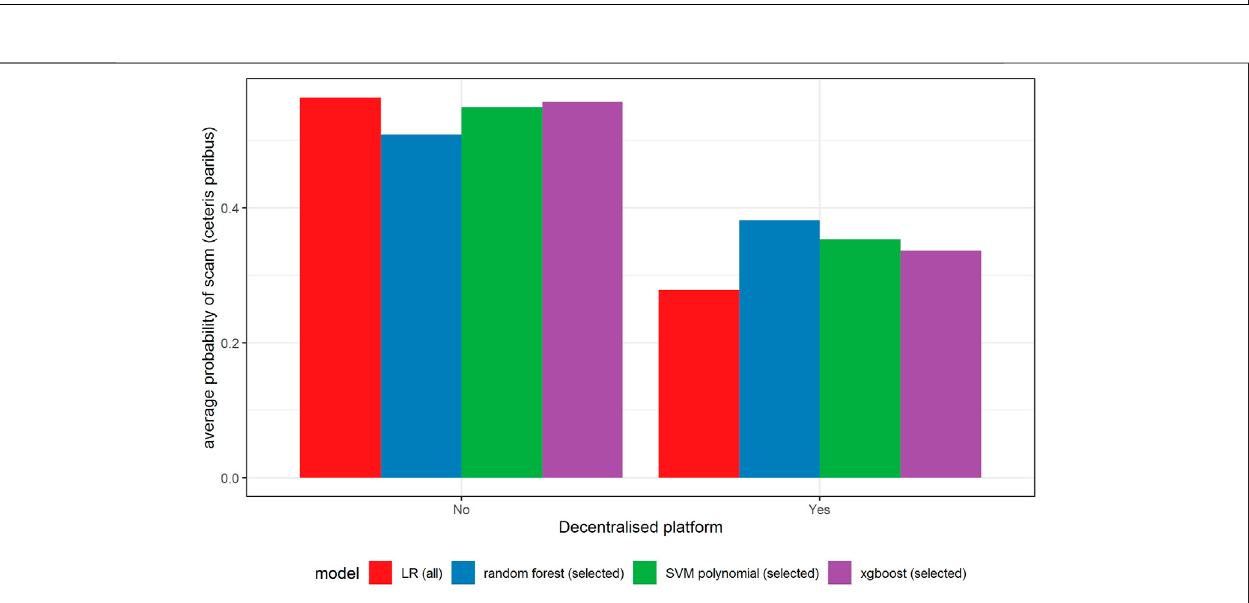
FIGURE 7 | Partial dependence plot for variable indicating decentralized